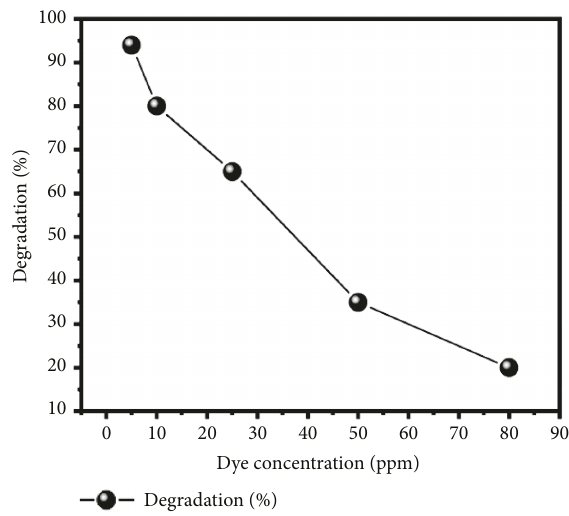
Figure 12: Effect of MB concentration on degradation